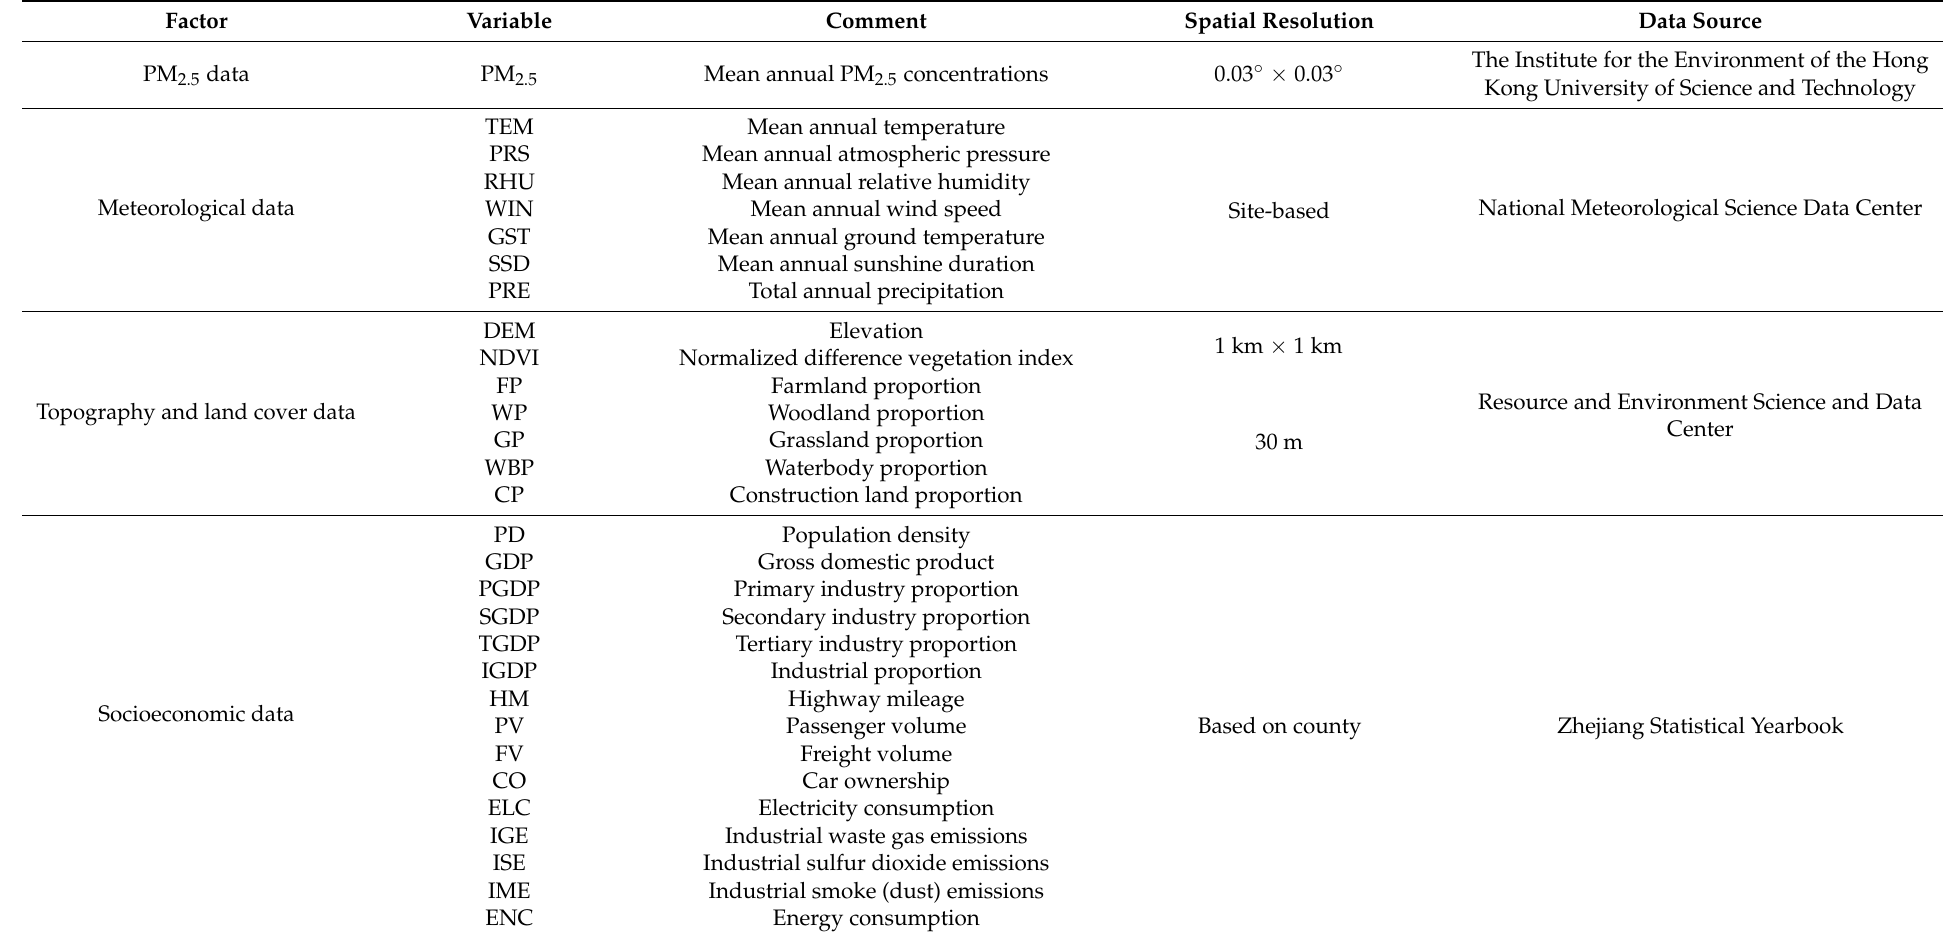
Table 1. Variables used in this